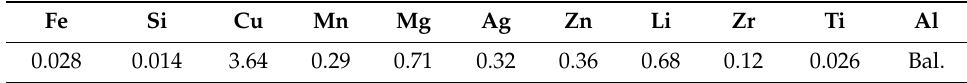
Table 1. Chemical composition of Al-Li alloy (wt %).